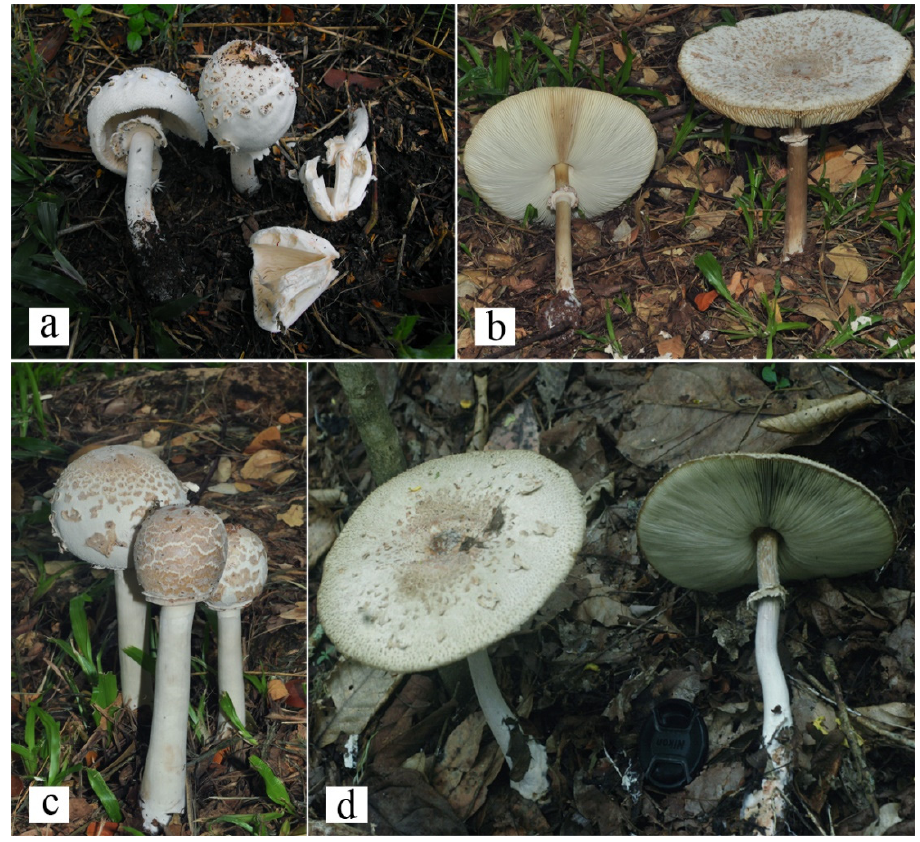
Figure 7. Fresh basidiomata of Chlorophyllum globosum in situ. ( a ) MFLU 12-1815. ( b , c ) MFLU 192357. ( d ) MFLU 10-0555. Pileus 50–200 mm, subglobose to globose when young, expanding to parabolic to con- vex, plano-concave when fully mature, with straight or slightly inflexed margin; glabrous at the center, pale-orange to brownish-orange (5A2–3, 6C7–8), with concolorous patches of irregular shapes around the center and scatted towards the margin and fragile when mature, on white to yellowish-white (2A2, 3A2, 4A2) felted or fibrillose background and turning pastel red to red (9A4–6) when touched; margin white, sulcate, but non-striate, not fringed, exceeding lamellae when mature. Lamellae free, slightly remote from the stipe, white to orange-white (5A1–2) when young, turning pastel red to red (9A4–6) when touched, pastel green to grayish-green (29A4, 29B4) when fully mature, crowded, ven- tricose, and narrowly to pileal margin, up to 20 mm wide, with the eroded edge. Stipe 85–210 × 12–31 mm, tapering to apex, with bulb-like, 30–34 mm wide base; white to brownish-orange (6C3–6) background, sometimes with some white fibrils at apical zone, turning pastel red to red (9A4–6) when touched, with white rhizomorphs connected to the substrate. Annulus under-developed, cuff-like, moveable when mature, white and fibrillose in the upper part, at underside with squamules similar to the patches on the pileus. Context thick and white in pileus, white in the stipe, brownish-orange (6C3–6) at apical zone, paler in the middle zone, and white toward the base, turning pastel red to red (9A4–6) in both pileus and stipe context. Smell and taste not observed. Spore print dull green to grayish-green (29D3–5,